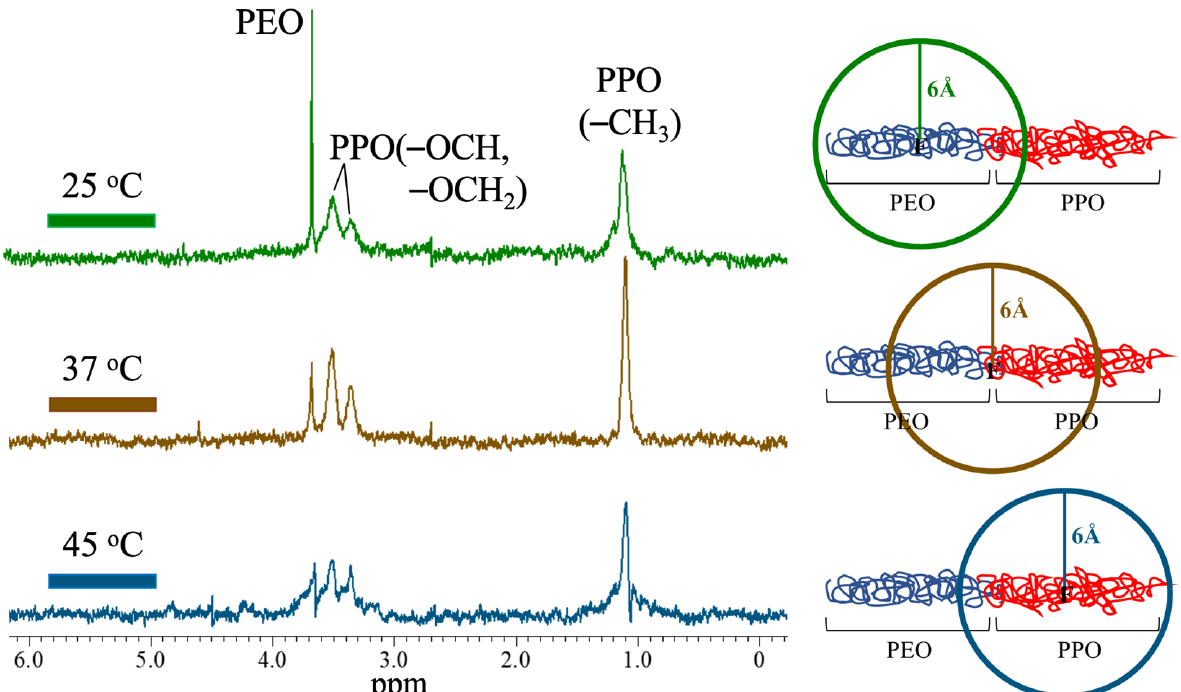
Figure 3. ( Left ): HOESY of the Pluronic blending composites with volume ratio of F127/L121 = 1/3 at 25 ◦ C, 37 ◦ C, and 45 ◦ C. ( Right ): Schematic illusion of the molecular chain model in the spectra of HOESY.